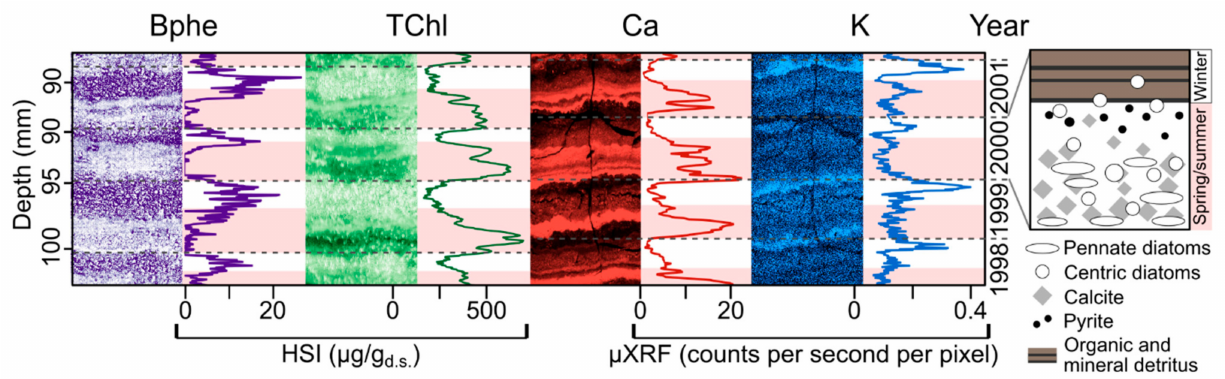
Figure 4. Close-up of varves (representing four years) in sediments of Lake ˙Zabi´nskie showing seasonal-scale variations in sedimentary pigments (Bphe = bacteriopheophytin a , TChl = total chloropigments) inferred from HSI. Bphe indicates the presence of purple sulfur bacteria and strongly anoxic conditions. TChl is a proxy for total algal production. Elemental data from µ XRF imaging (Ca, K) are from resin-embedded sediment slabs. Ca represents mainly endogenous calcite precipitation during the warm season. K is indicative of more clastic sediment and typically peaks during ice cover in winter due to the settling of fine minerogenic material and limited primary production/calcite precipitation under ice cover. Gray, dashed lines indicate varve (annual layer) boundaries; pink bars indicate spring/summer layers. Right inset shows schematic microfacies of a single varve year. Modified from Zander et al. [47] and ˙Zarczy´nski et al.